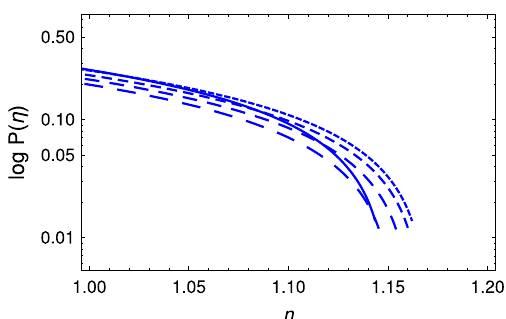
Fig. 2 Logarithmic plot of pressure for the same values of B 2 used in Fig. 1